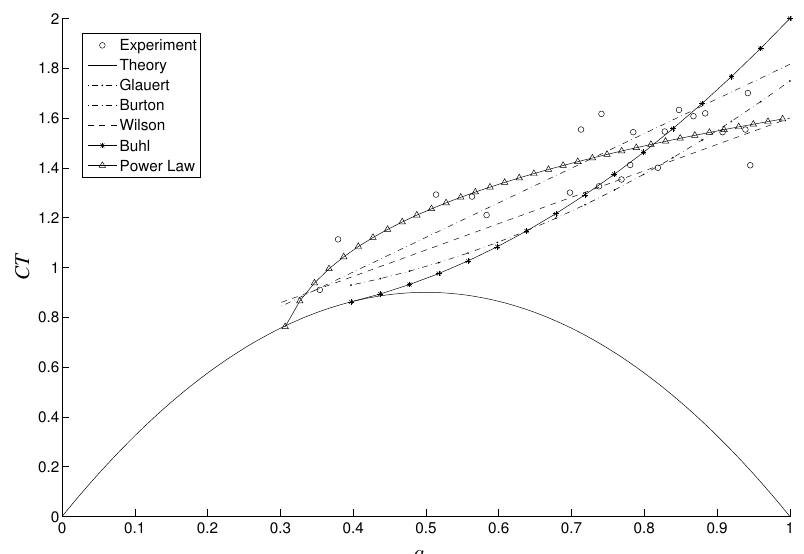
Figure 3. Coefficient of thrust CT versus the axial induction factor a . The parabola represents the relation as per the stream-tube theory; The empirical fitting curves proposed by Glauert [15], Buhl [19], Wilson [21] and Burton et al. [20] to the experimental data of Lock and Townend [41] and the Power-Law fitting proposed by Ponta et al. [22] are also shown. The theoretical CT curve shown here incorporates a tip-hub loss factor f th = 0.9 in order to illustrate the problem of discontinuity observed in Glauert’s